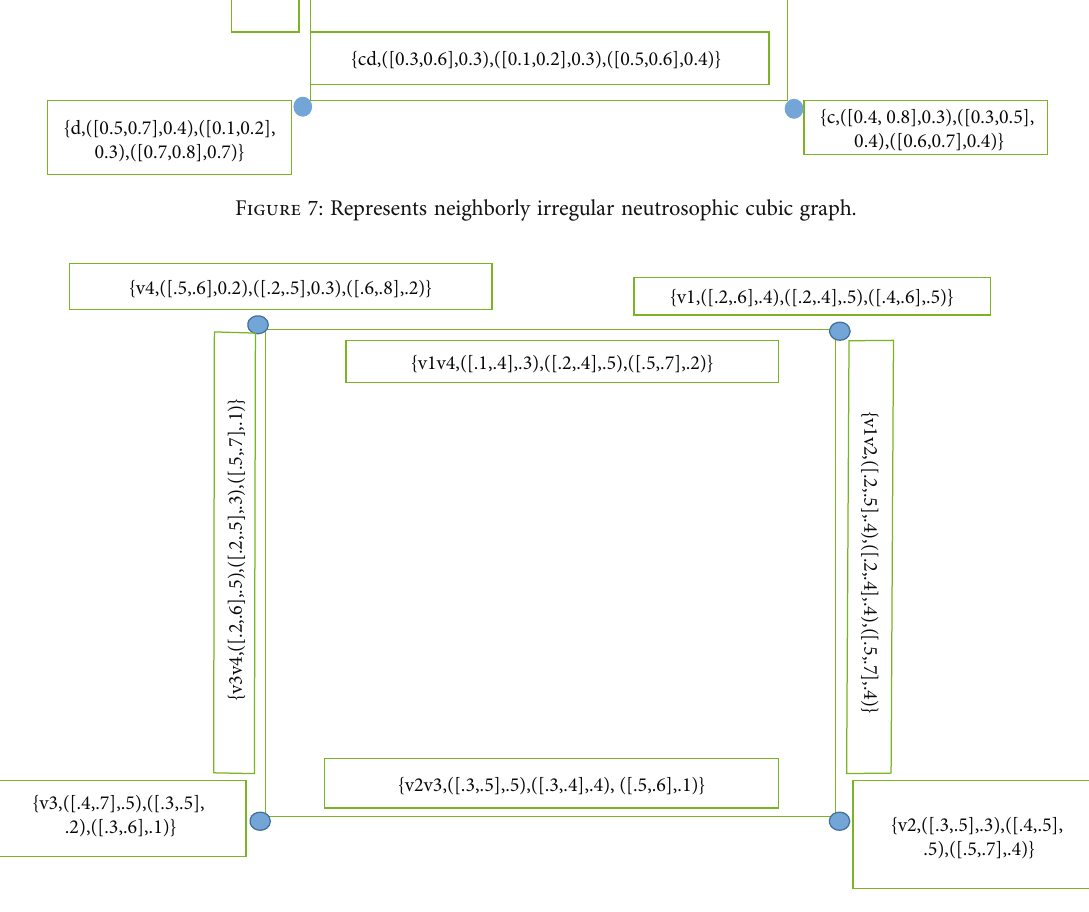
Figure 8: Represents neighborly totally irregular neutrosophic cubic